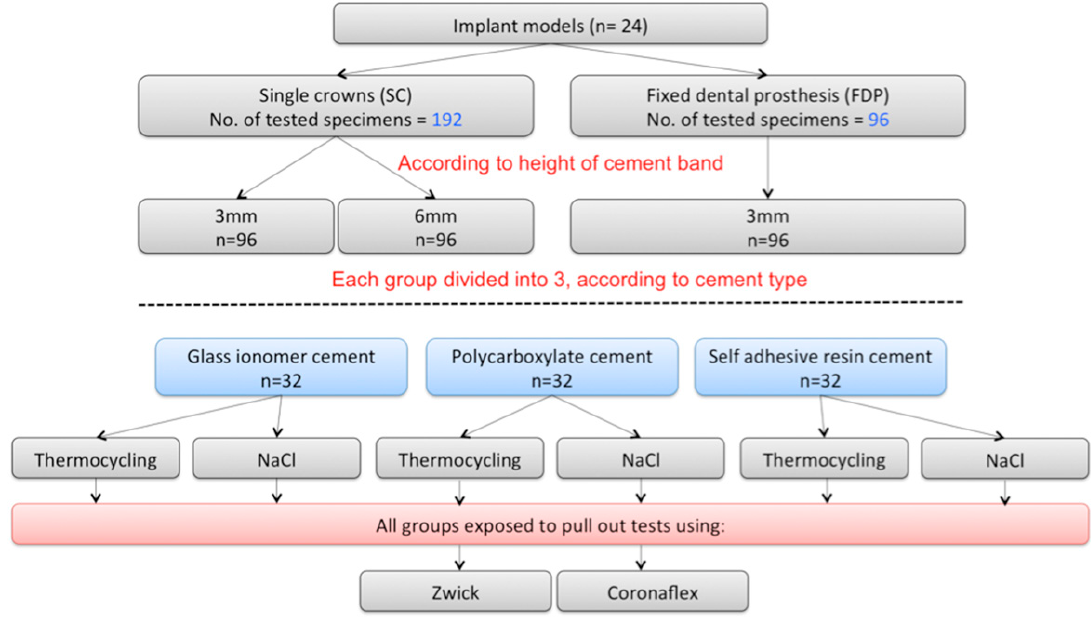
Figure 4. Workflow of the tests.